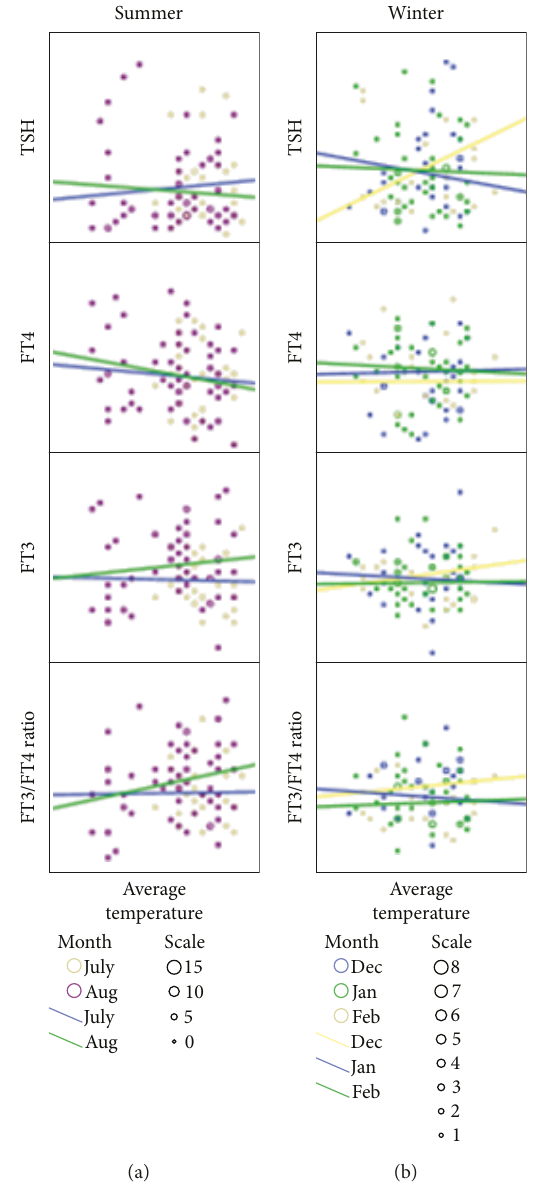
Figure 2: Changes of TSH, FT3, FT4, and FT3/FT4 ratio, according to the monthly temperature within the seasons. The scatter plots in both summer (a) and winter (b) are